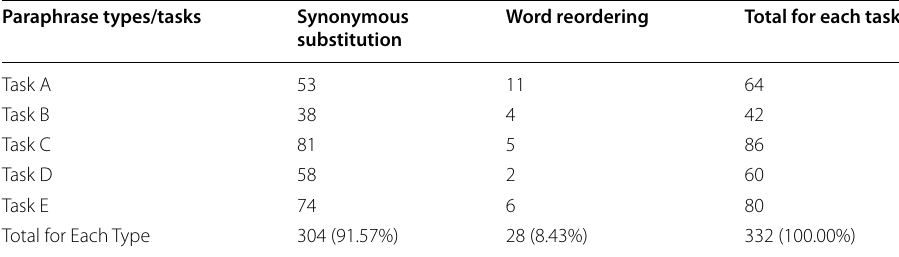
Table 3 Task wise paraphrase type statistics for the dataset Paraphrase